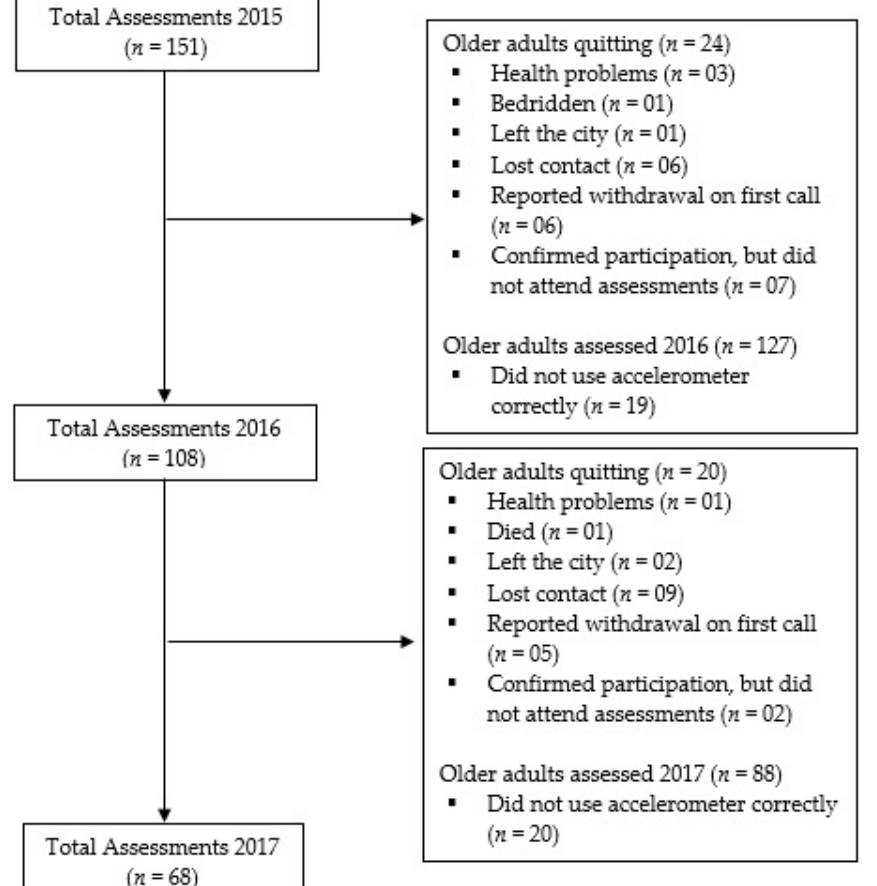
Figure 1. Flowchart of the older adults’ participation during the study.